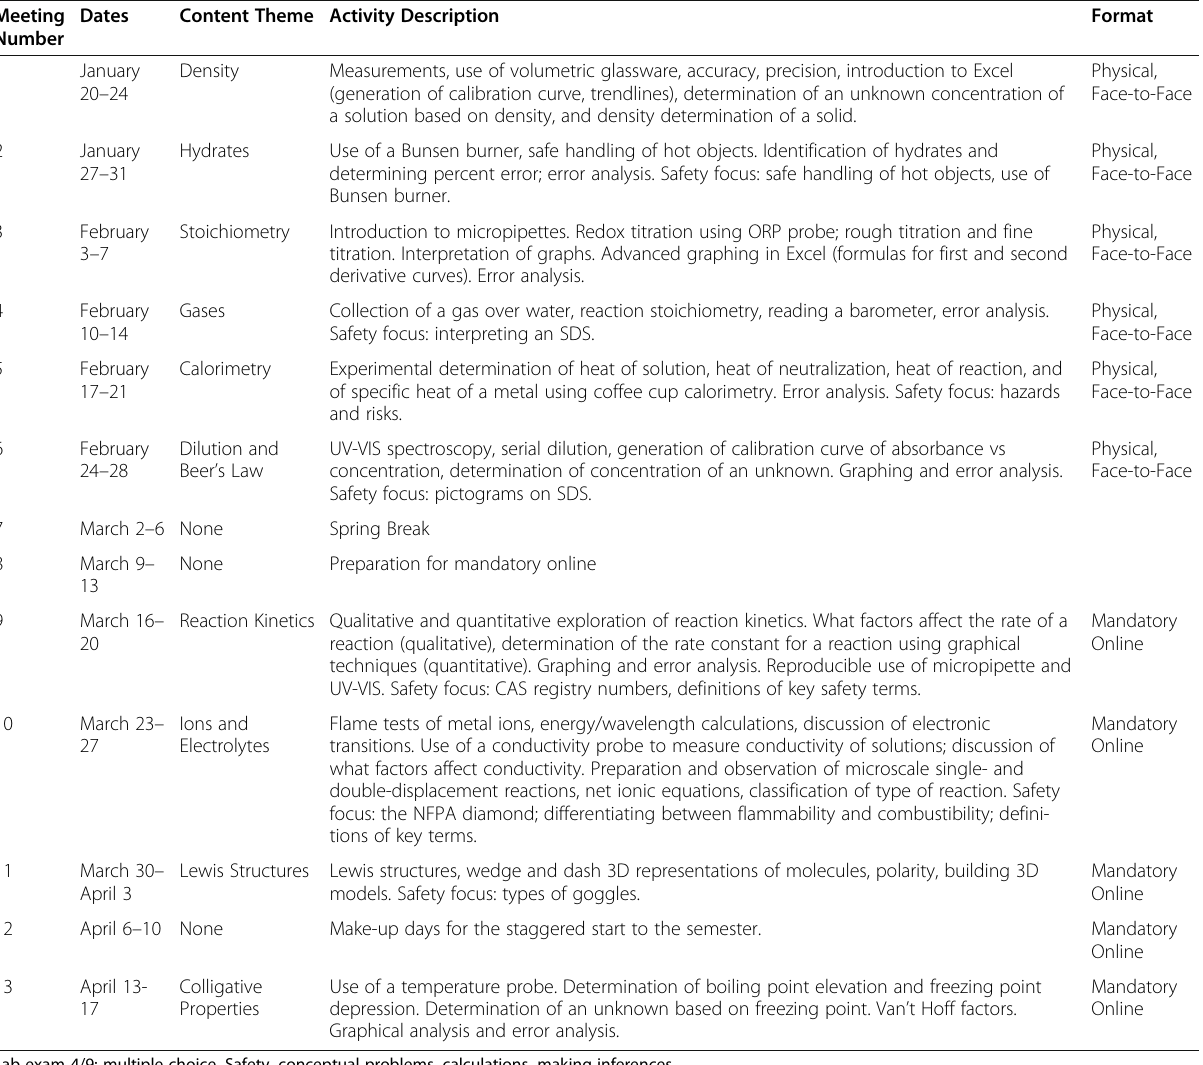
Table 1 Overview of the laboratory experiences for the